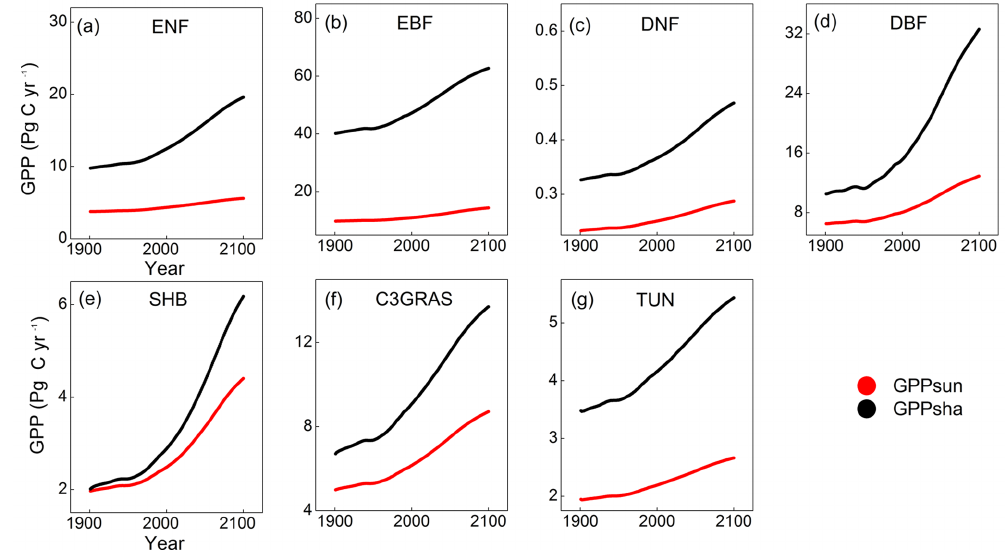
Figure 5. Temporal trends of GPP sun (red points) and GPP sha (black points) for C 3 PFTs from 1901 to 2100 from CABLE-C-only simulation. GPP sha is higher than GPP sun for all PFTs. With significant increase in CO 2 concentration from 2011, GPP sha responds more drastically than GPP sun . Abbreviations are the same as Fig.